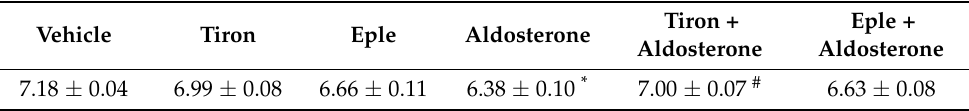
Table 1. pEC50 values for ACh-induced relaxation in the thoracic aortas of C57BL/6J treated with aldosterone in the presence of vehicle, tiron, or